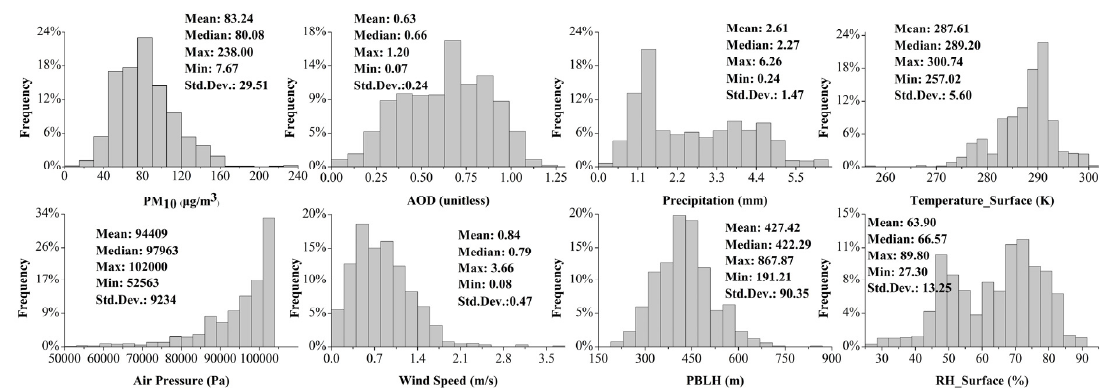
Figure 2. Histograms and descriptive statistics of the variables in the whole model fitting data set.